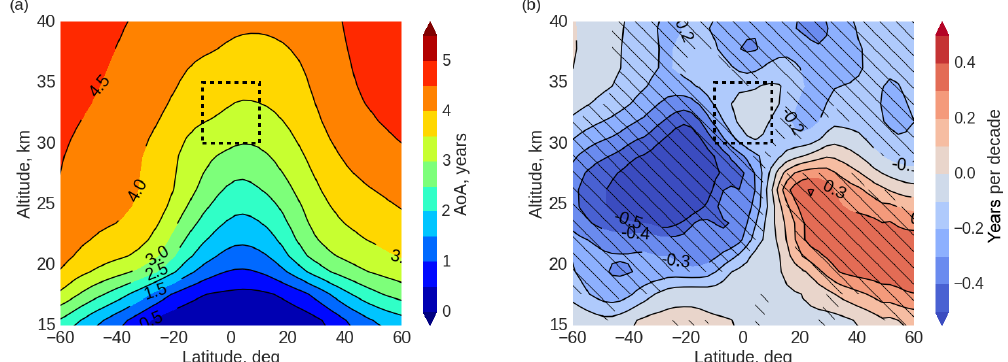
Figure 8. Latitude–altitude AoA (a) the zonally averaged distribution (years), (b) the linear changes (yearsdecade − 1 ) from the MLR model applied to the TOMCAT CNTL simulation during January 2004–April 2012: latitude range is from 60 ◦ S to 60 ◦ N, altitude range is from 15 to 40km. The dashed rectangle indicates the region of interest in the tropical mid-stratosphere. The hatched areas in (b) show changes significant at the 2 σ